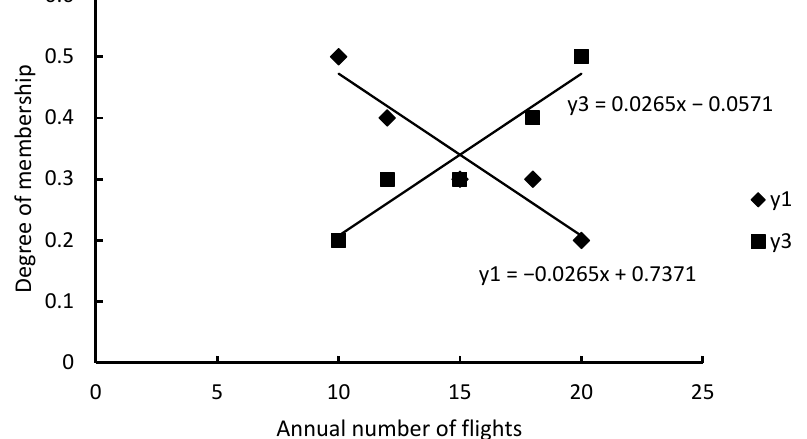
Figure A28. Single factor evaluation for the index of annual number of flights (11–20 times).